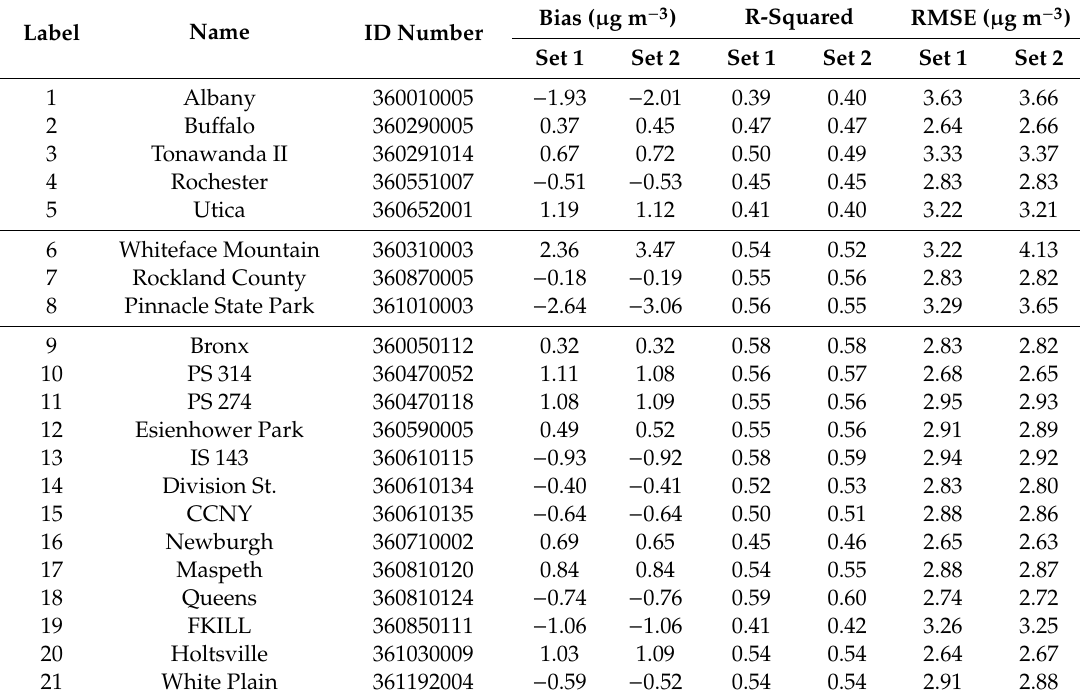
Table A2. LOOCV testing results of the MLR models at selected air quality sites.